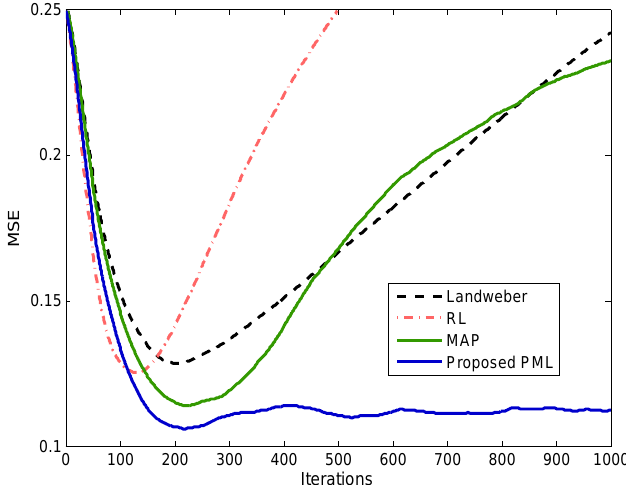
Figure 7. Mean square errors (MSE) curves comparison when SNR = 20